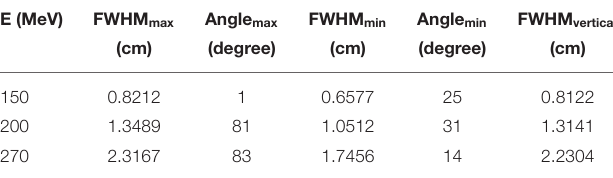
TABLE 3 | Dose calculations on different angle